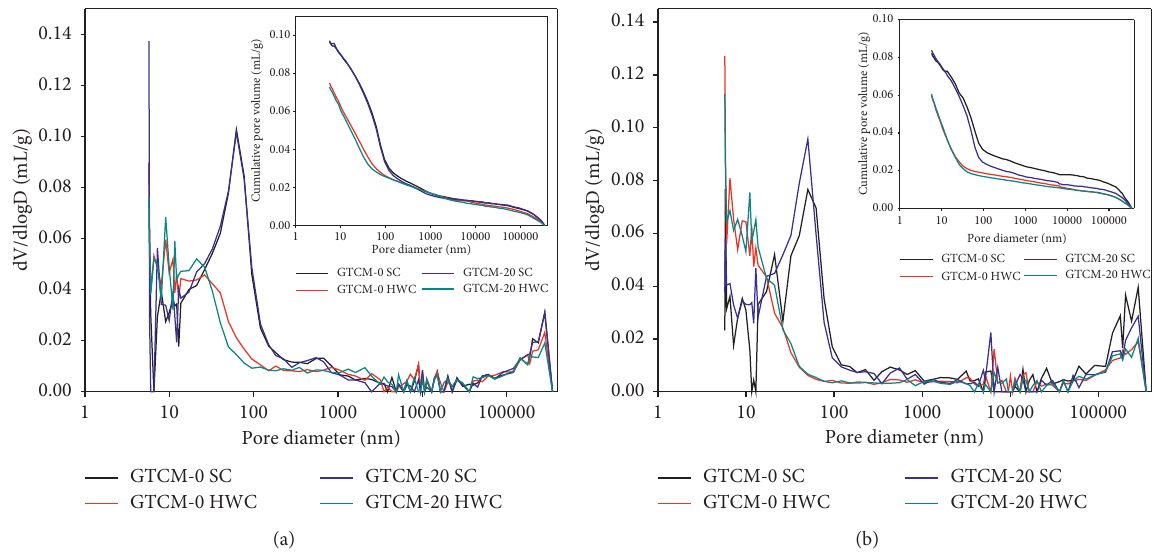
Figure 11: Pore size distribution of GTCM-0 and GTCM-20 under SC and HWC methods: (a) 1 day and (b) 3 days.